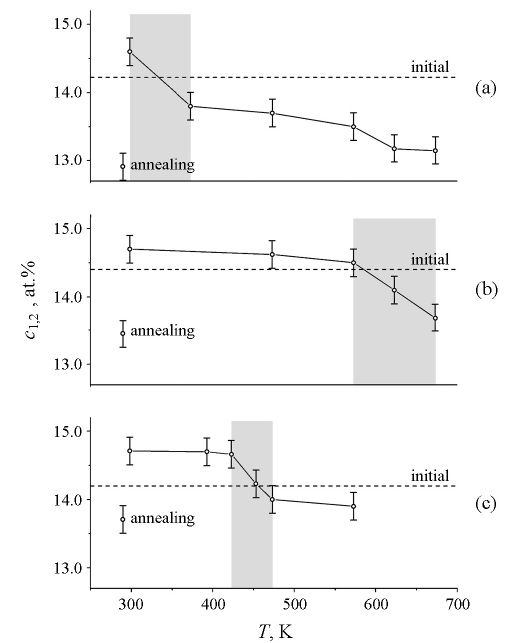
Figure 5. Dependence of c 1,2 on the temperature of deformation of alloys: ( a )—Fe-16Cr; ( b )—Fe-16Cr-Sb, and ( c )—Fe ‐ 16Cr ‐ Au. Dash line designates the value of c 1,2 in the initial state of the alloys. Dot designates the value of c 1,2 in the alloys after annealing at 773 K, 1 h. Darkening marks the region of accelerated altering of c 1,2 vs. the temperature of deformation.